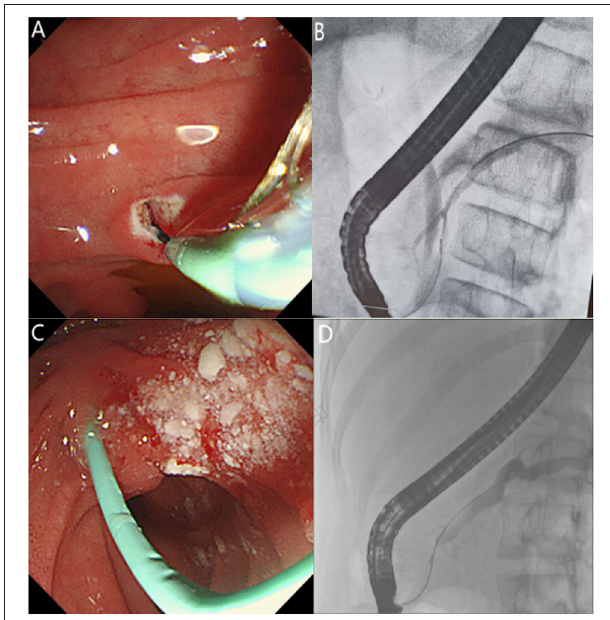
FIGURE 1 | (A) Endoscopic view of pancreatic sphincterotomy through the minor papilla. (B) Fluoroscopic view of the endoscopic retrograde cholangiopancreatography showing a small ventral pancreatic duct and large dorsal pancreatic duct in incomplete pancreas divisum. (C) Endoscopic view showing that a pancreatic stent was placed through the minor papilla after stone extraction. (D) Fluoroscopic view of pancreatic duct dilation and stricture.